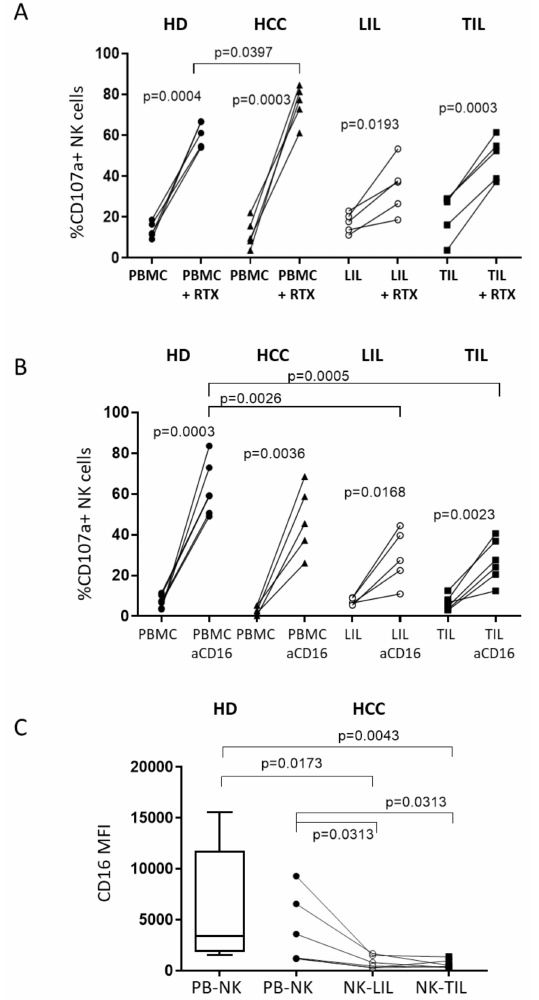
Figure 7. CD16-mediated NK activity. ( A ): NK cell cytotoxicity of HD ( n = 6) and HCC patients (peripheral and liver compartments, n = 5) for Daudi cells after stimulation with IL-15 before and after the addition of anti-CD20 mAb ( + RTX). ( B ): CD107a expression in NK cells from HD ( n = 5) and HCC patients (peripheral and liver compartments, n = 5) after stimulation with IL-15, with or without coating with anti-CD16 (aCD16) mAb. ( C ): Expression of CD16 on patients PB-NK, NK-LIL, and